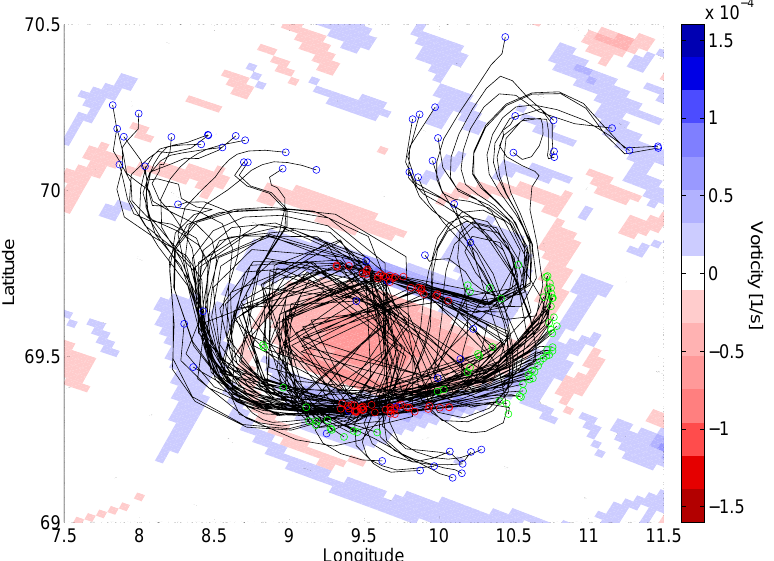
Fig. 5. Surface particle trajectories for a subset the particles that were aggregated in the high-vorticity region after 4 days of simulation. The trajectories are shown on top of the vorticity field on the same day in model layer 5 (16–21m). Green circles indicate the initial position, red circles indicate the position on day 4, and blue circles indicate the final position after 20 days. The straight lines in some of the trajectories occur because the particle positions were only saved every